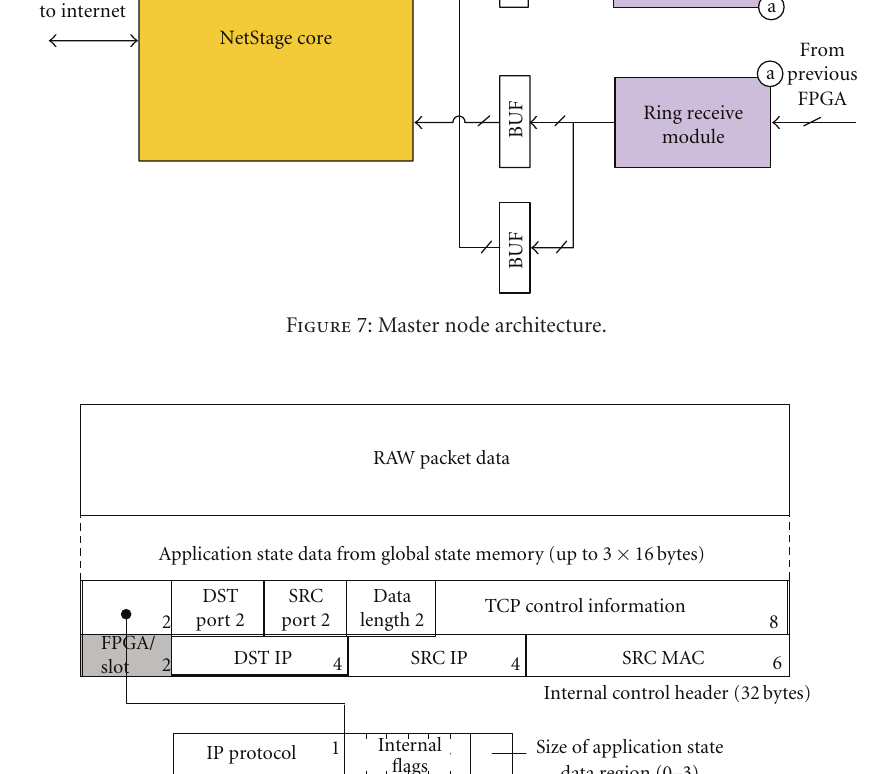
Figure 8: Structure of the internal control